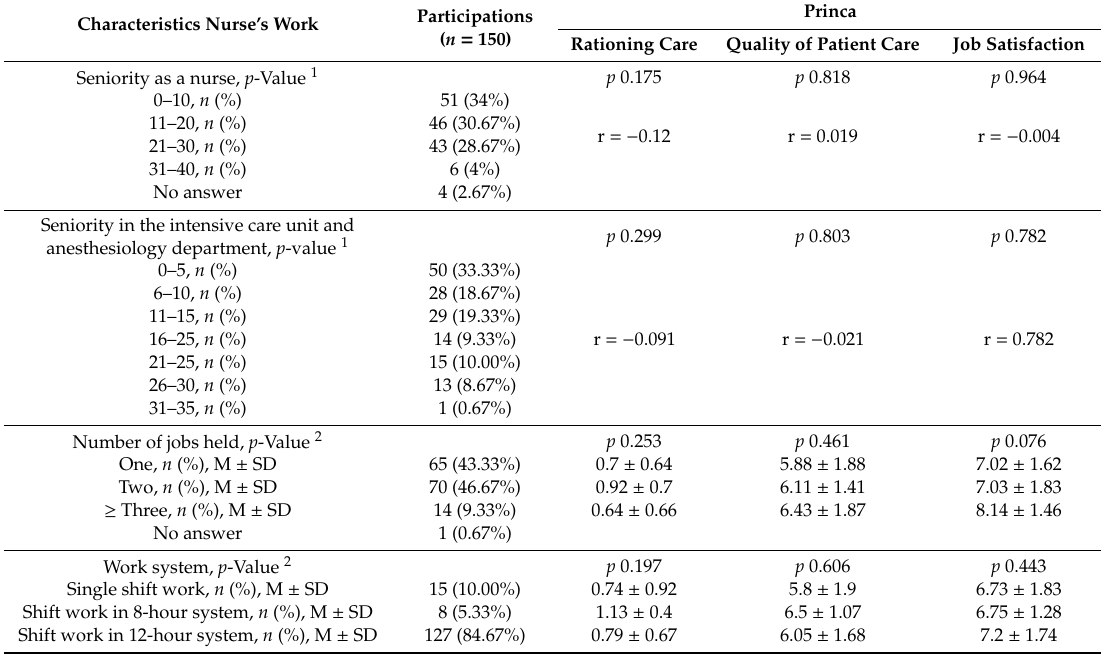
Table 2. The work characteristics of respondents compared with the rationing of nursing care.